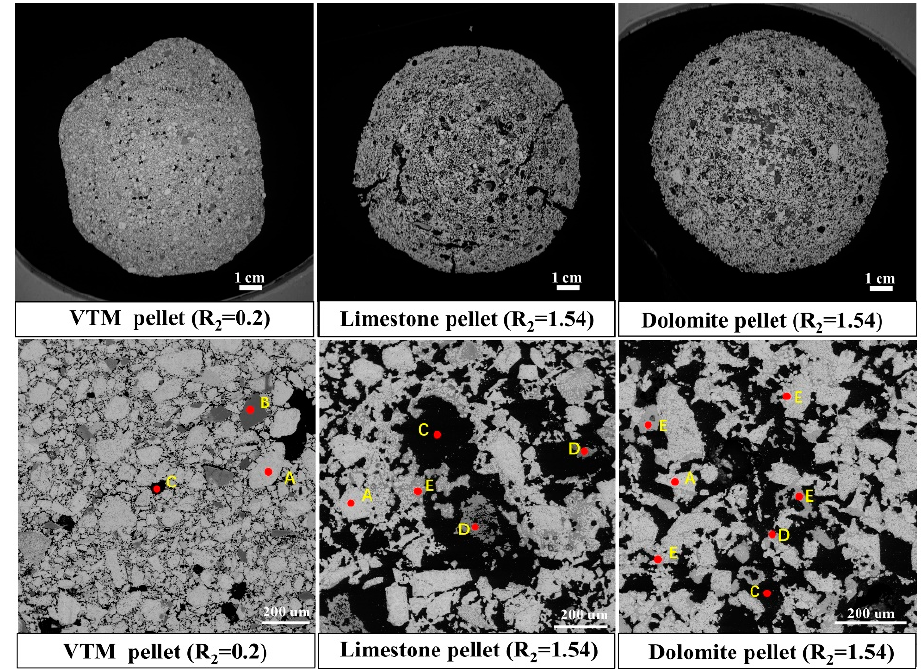
Figure 6. SEM chart of the microstructure of roasted pellets with different types of fluxes. (A) Hematie (Fe 2 O 3 ); (B) iron titanium (Fe 0 . 975 Ti 0 . 025 ); (C) pore; (D) andradite titanian (Ca 3 Fe 2 (Si 1 . 58 Ti 1 . 42 O 12 )); (E) Magnesium Aluminum lron Oxide (MgAl 2 Fe 1.8 O 4 ).